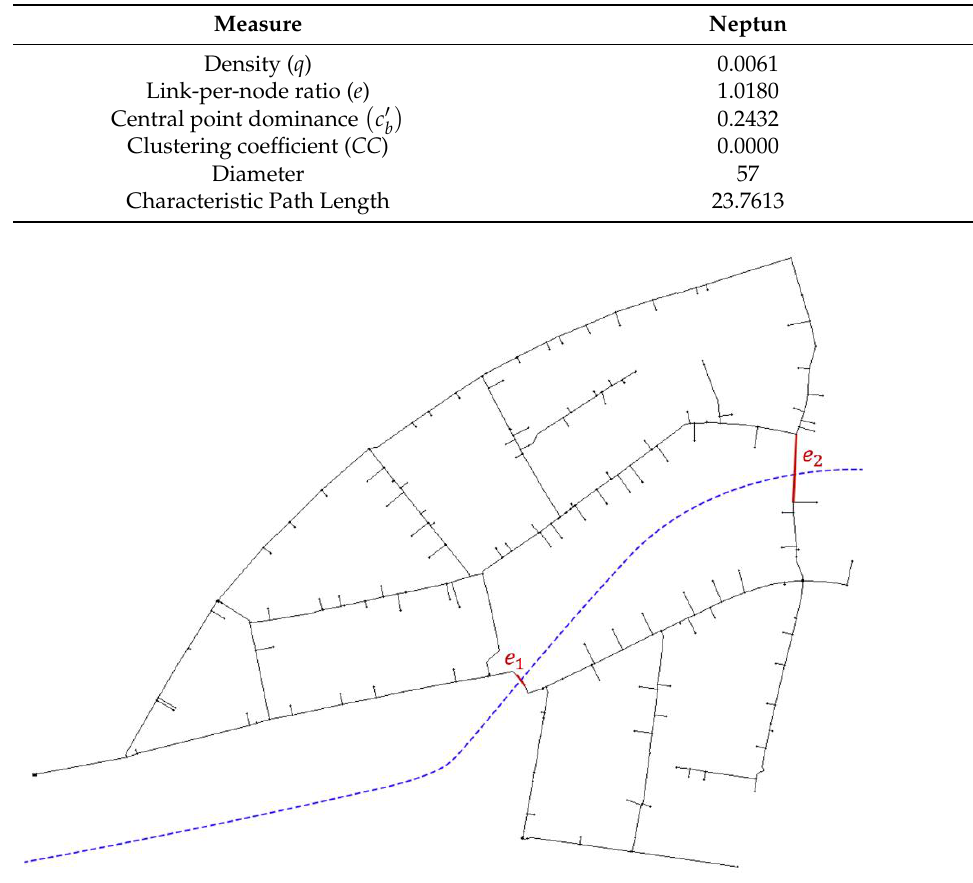
Figure 3. Critical edges (red) highlight a cut-set in Neptun consisting of 2 edges (bridges) whose simultaneous removal generates a disconnection.